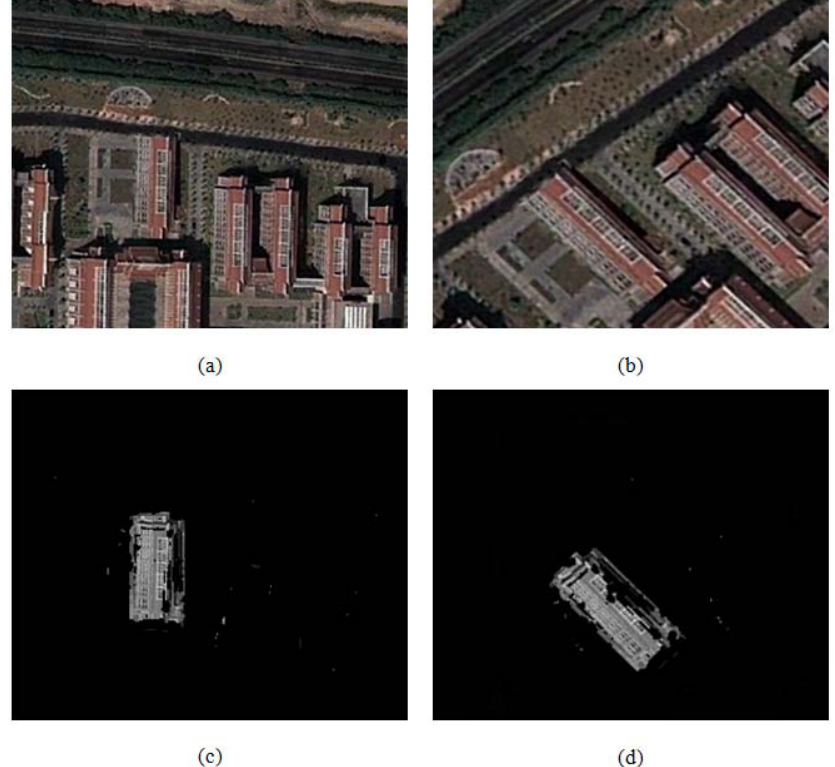
Fig. 8. (a) Reference image, (b) Sensed image, (c) Ground-truth map of the changed area. (d) Reference map of the changed area. The second experiment conducted on a 2×2 sub-sampling of the sensed image (Fig. 9(a)). Our goal here is to demonstrate the scale invariant of SIFT approach. Figure 9(b) illustrates the obtained change detection map in this simulation. The result is a little